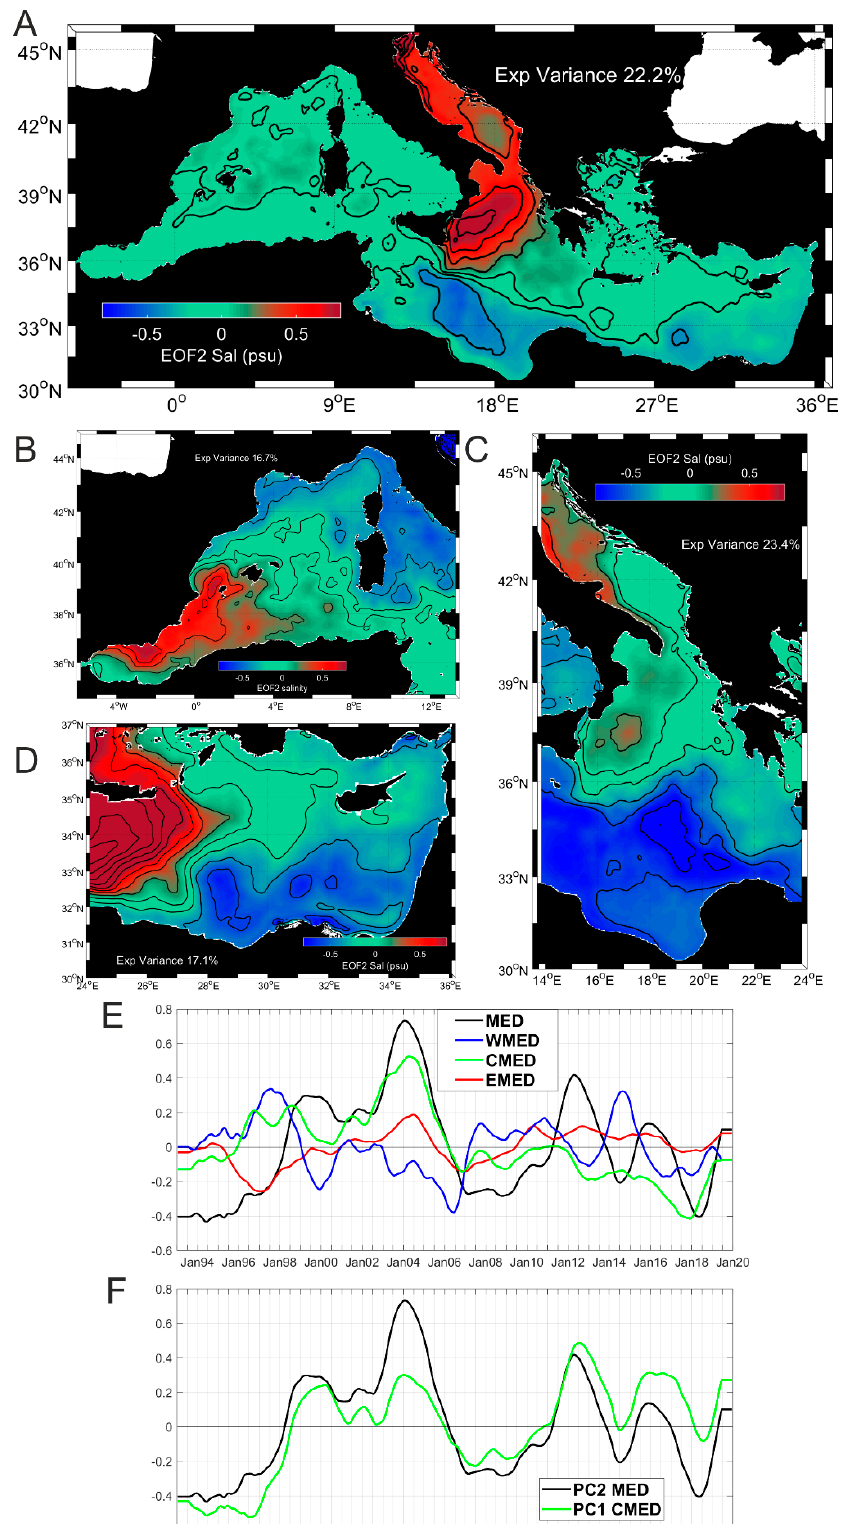
Figure 8. EOF2 of the SSS for the MED ( A ), WMED ( B ), CMED ( C ), and EMED ( D ), and relative PC2s ( E ); comparison between the PC1 of SSS in the CMED and the PC2 of SSS in the MED ( F ).